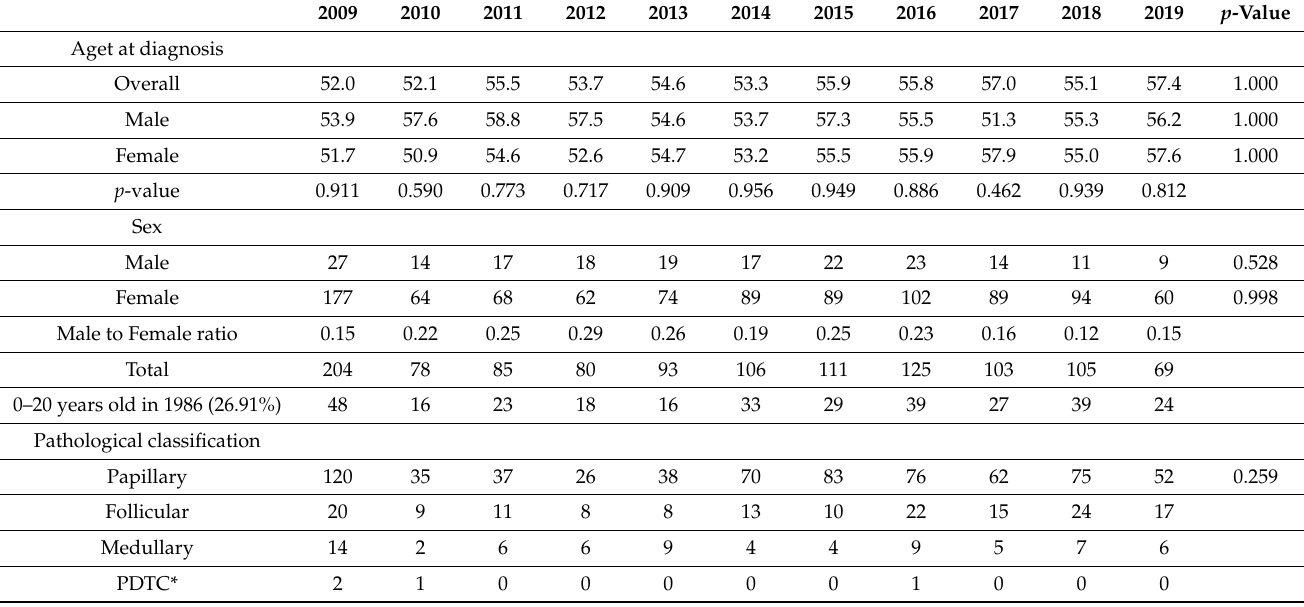
Table 2. Timeline characteristics of this study (age, sex, histopathological).